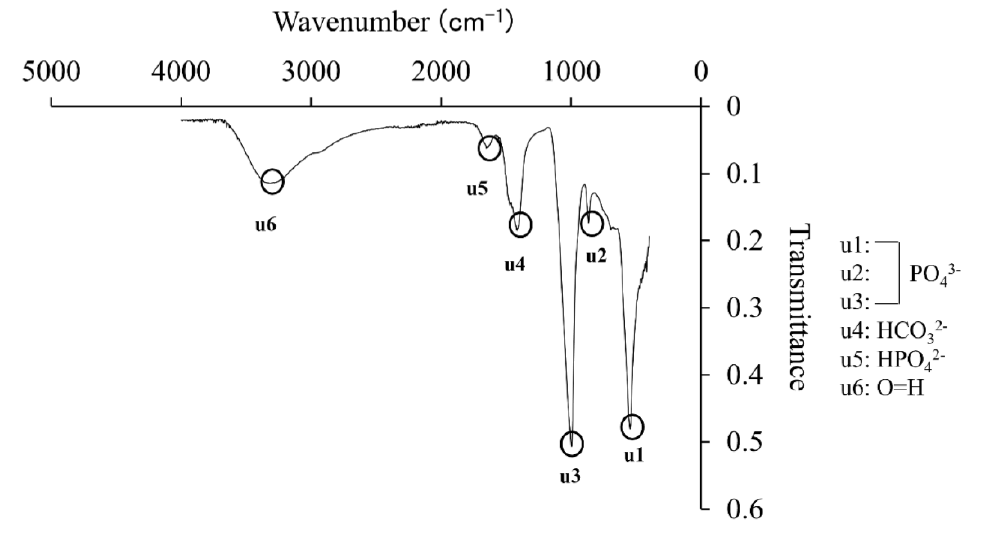
Figure 5. XRD analysis of ( a ) the peak of precipitate, ( b ) the peak of HA granules.